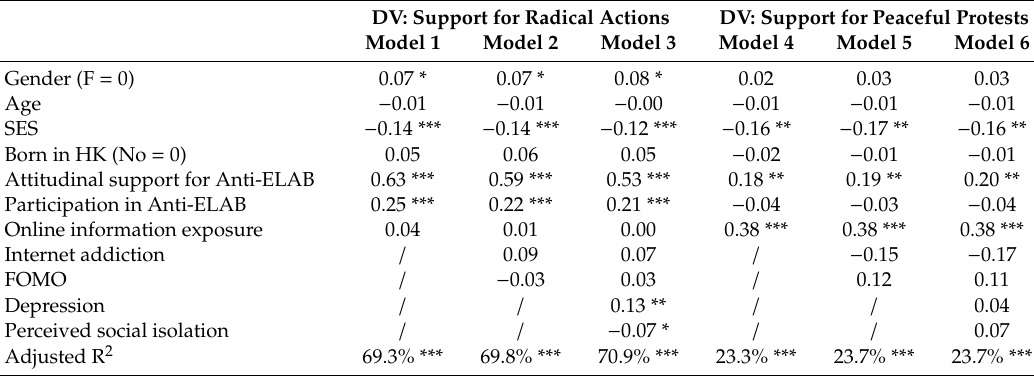
Table 3. Regression analysis for support for radical protests and peaceful